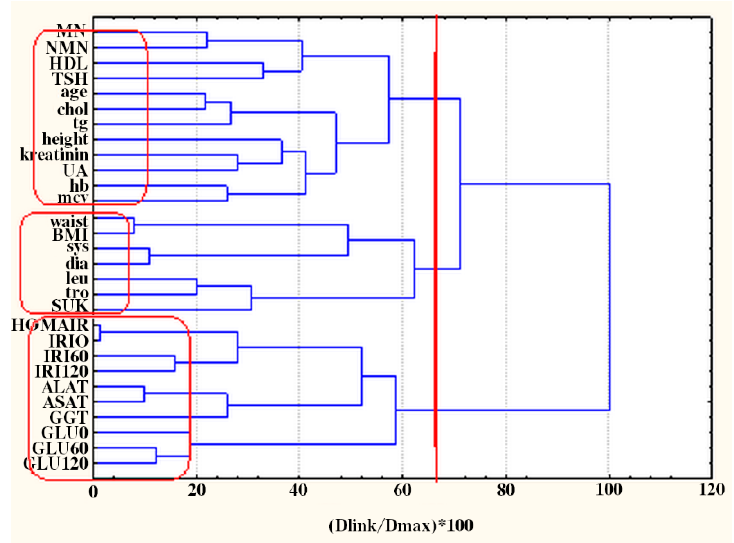
Figure 1. Hierarchical dendrogram for clustering of 29 variables. The included variables with their abbreviations are metanephrine (MN), normetanephrine (NMN), age, height, waist, body mass index (BMI), HOMA-IR, systolic blood pressure (sys), diastolic blood pressure (dia), leucocytes (leu), hemoglobin (hb), thrombocytes (tro), mean corpuscular volume (mcv), total cholesterol (chol), HDL-cholesterol (HDL), triglycerides (tg), fasting glucose (GLU0), glucose at the first hour post glucose load (GLU60), glucose at the second hour post glucose load (GLU120), creatinine (kreatinin), alanine aminotransferase (ALAT), aspartate aminotransferase (ASAT), gamma-glutamyl transferase (GGT), uric acid (UA), fasting insulin (IRI0), insulin at the first hour post glucose load (IRI60), insulin at the second hour post glucose load (IRI120), free urine cortisol (UFC), and thyroid stimulating hormone